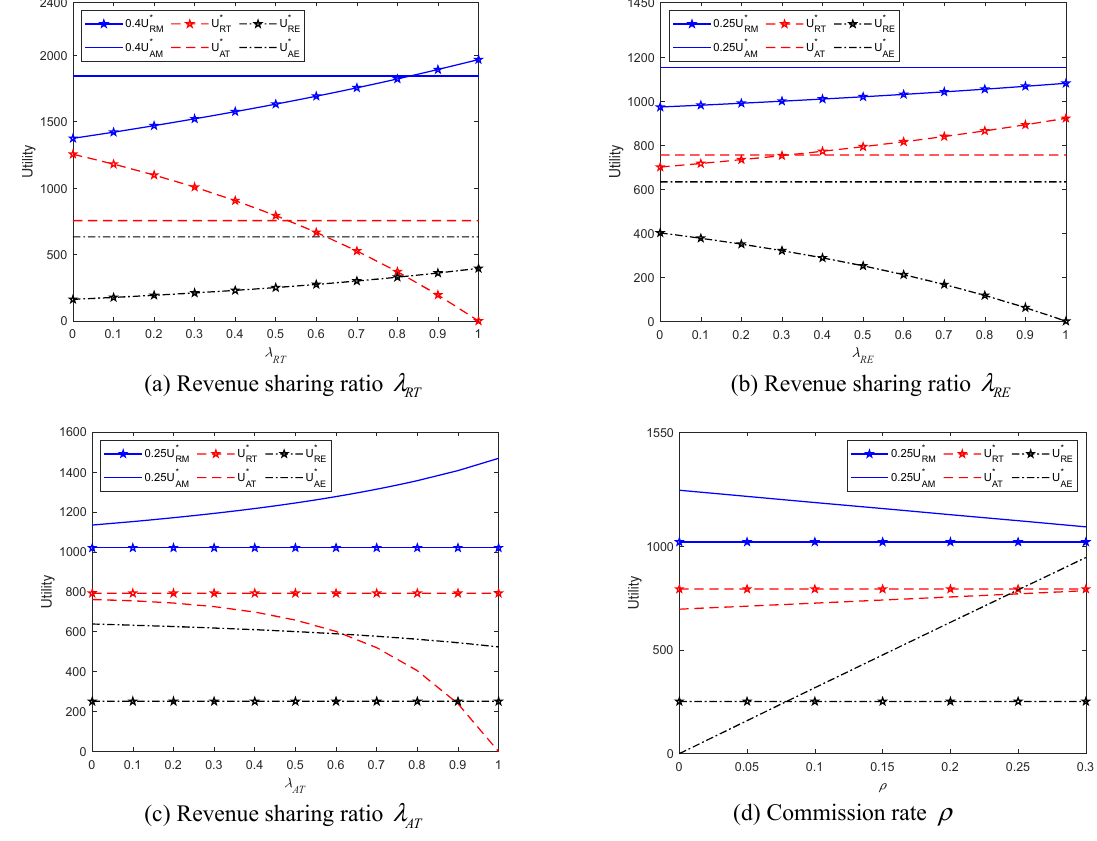
Fig. 6. Impact of RSC on optimal